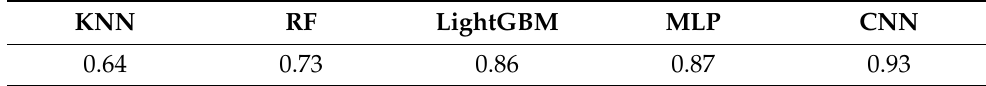
Table 4. Structural comparison of developed models by MSSIM